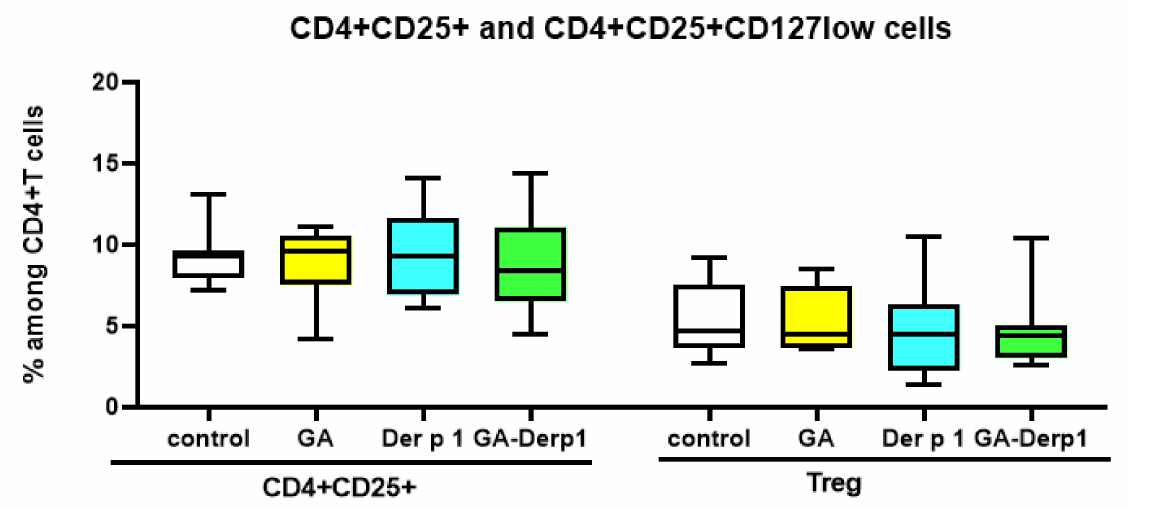
Figure 5. CD4+ cell subsets after cultivation with GA–Der p 1 mixture. Data are presented as box- and-whisker plots, with boxes extending from the 25th to the 75th percentile, with a horizontal line at the median, while the whiskers extend to the lowest and highest data points (n = 10).